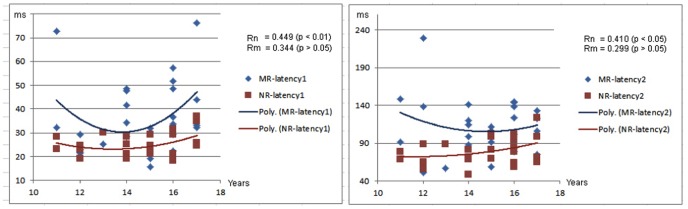
Correlation between age and responding latencies elicited by right finger movement.Two charts show the statistical correlation between age and latencies of movement-evoked magnetic fields (MEFs) from right finger movement. There are positive correlations between age and the latencies of MEFs in healthy controls. However, there is no significant correlation between age and the latencies of MEFs in children with migraine. The Y-axes are latencies of MEFs in milliseconds (ms); the X-axes are ages of children in years (Years). “MR” indicates children with migraine with right finger movement; “NR” indicates healthy controls with right finger movement. “Rn” indicates the correlation in healthy controls; “Rm” indicates the correlation in children with migraine.